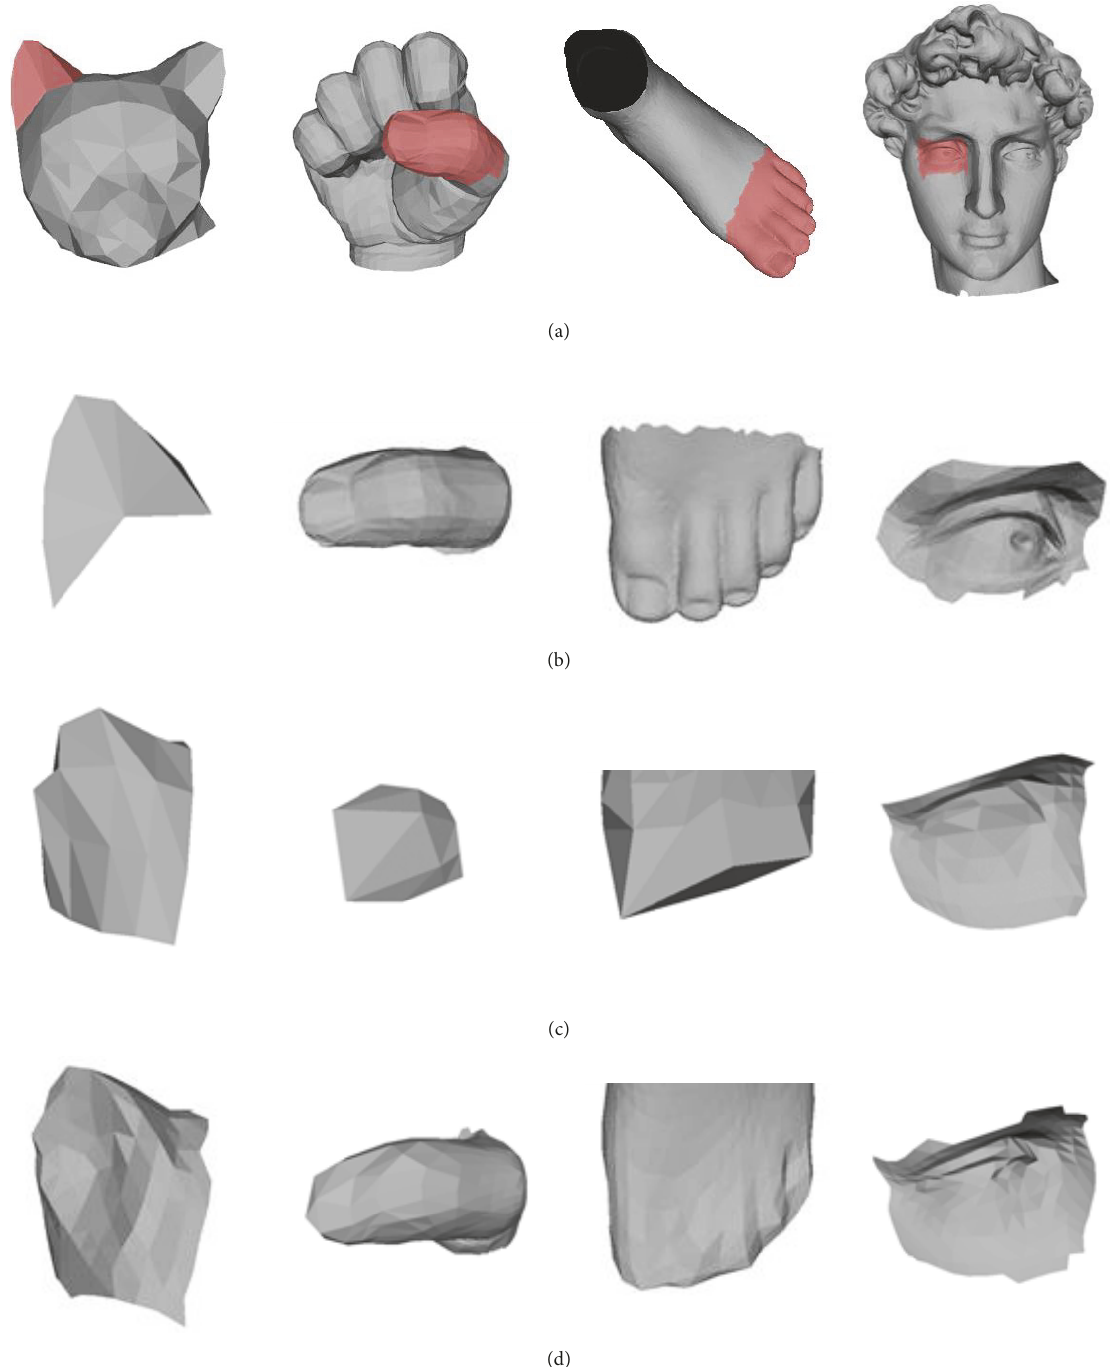
Figure 10: Qualitative results of ROI reconstruction. (a) to (d): original meshes, amplified details, reconstructions with traditional sampling rate, and reconstructions with increasing